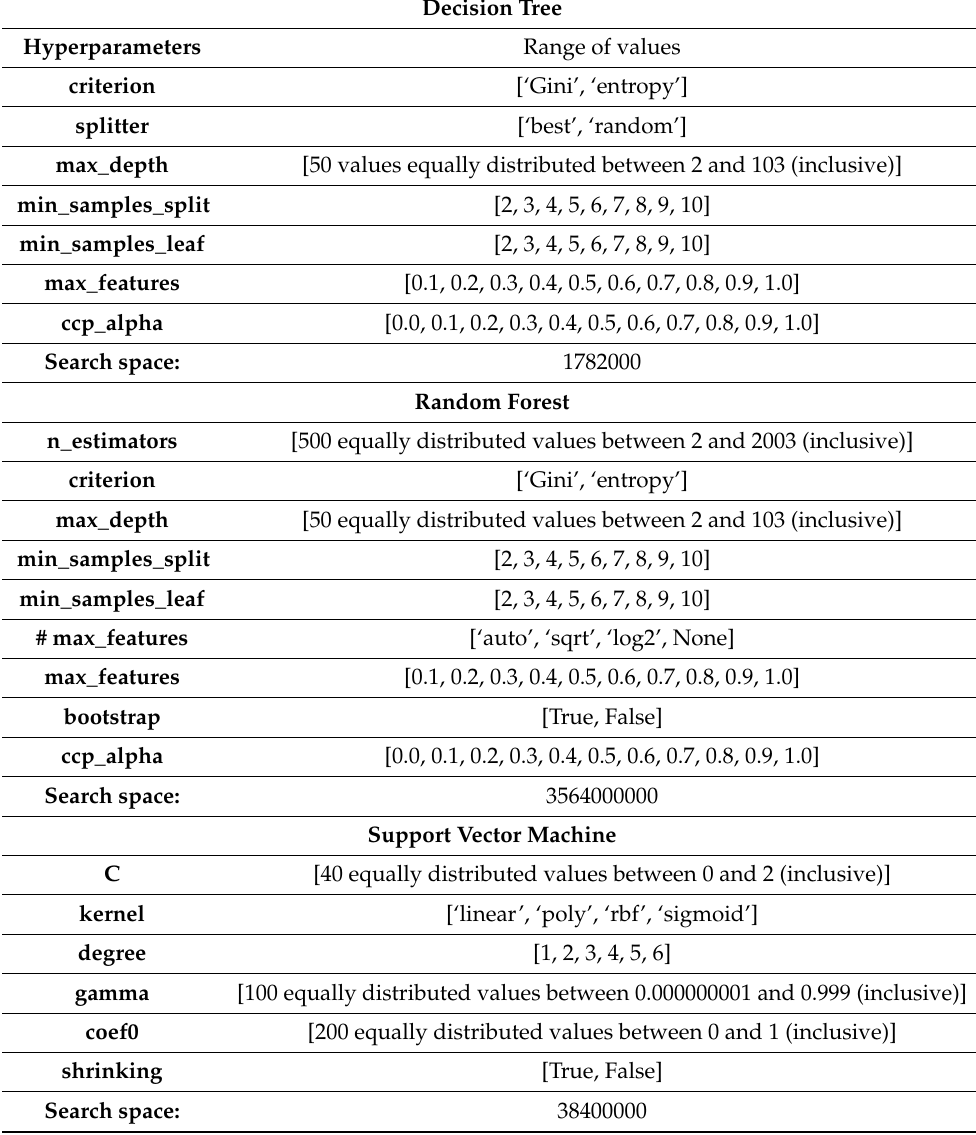
Table 4. Search space as defined for each